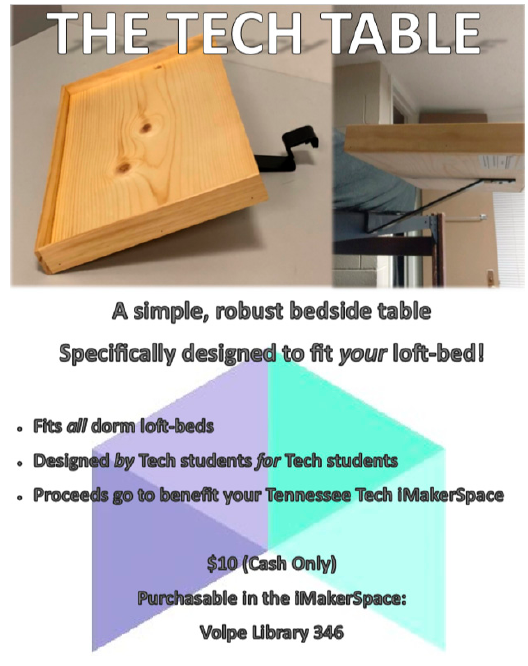
Figure 14. The Tech Table flyer .